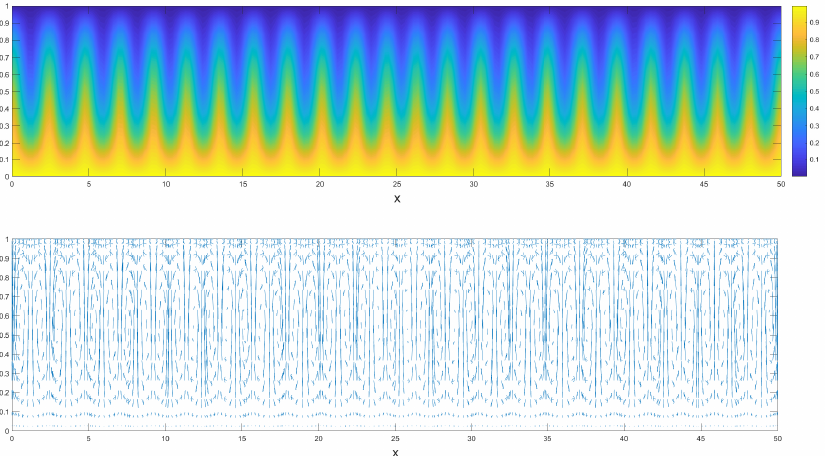
Figure 16. Isotherms and velocity field of a numerical solution obtained with alternating Schwarz domain decomposition; R = 1300, Γ = 50, np = 20, mp = 2, N × M = 16 × 10.